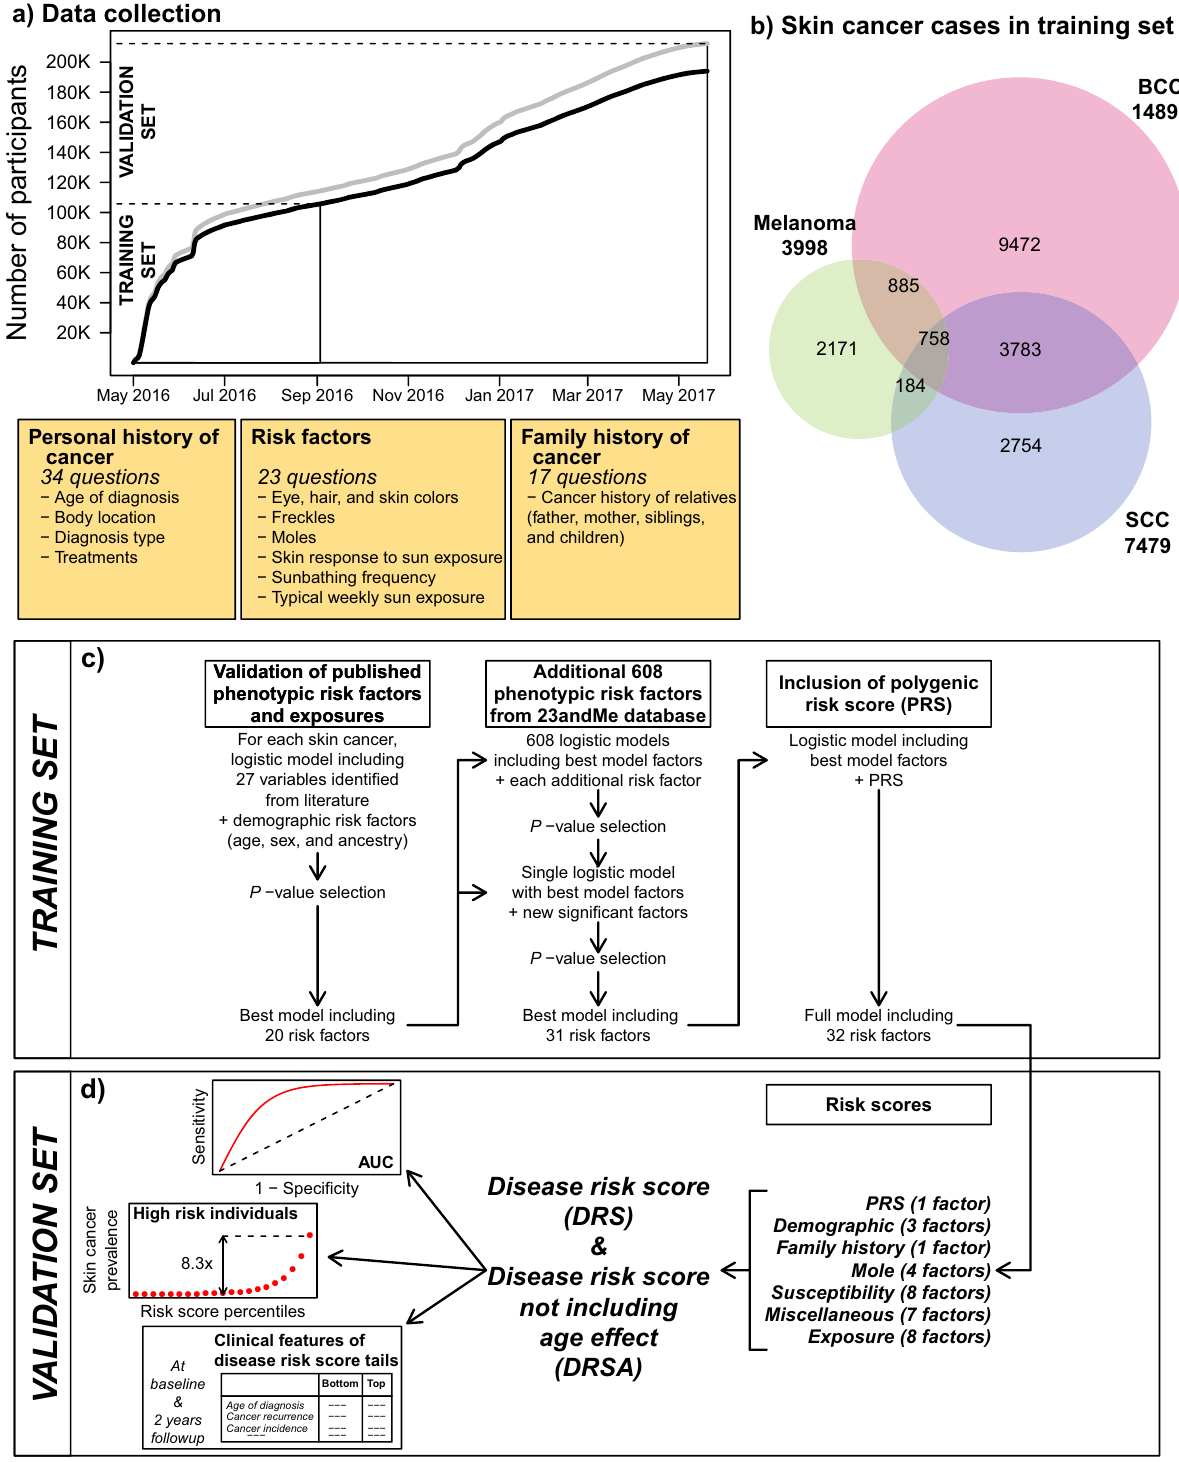
Fig. 1 Data collection for the training and validation sets, description of the cancer survey, overview of the predictive model construction, and disease risk scores. a Cumulative data collection from May 2016 to September 2016. Participants recruited between May and September 2016 were included in the training set. The gray line is the total number of participants from European ancestry. BCC, SCC, and melanoma prediction models were trained on participants 30 – 90 years old (black line). b Number of skin cancer cases in the training set. c Overview of prediction model construction in the training set. d Disease risk scores and predictive performances evaluated in the validation